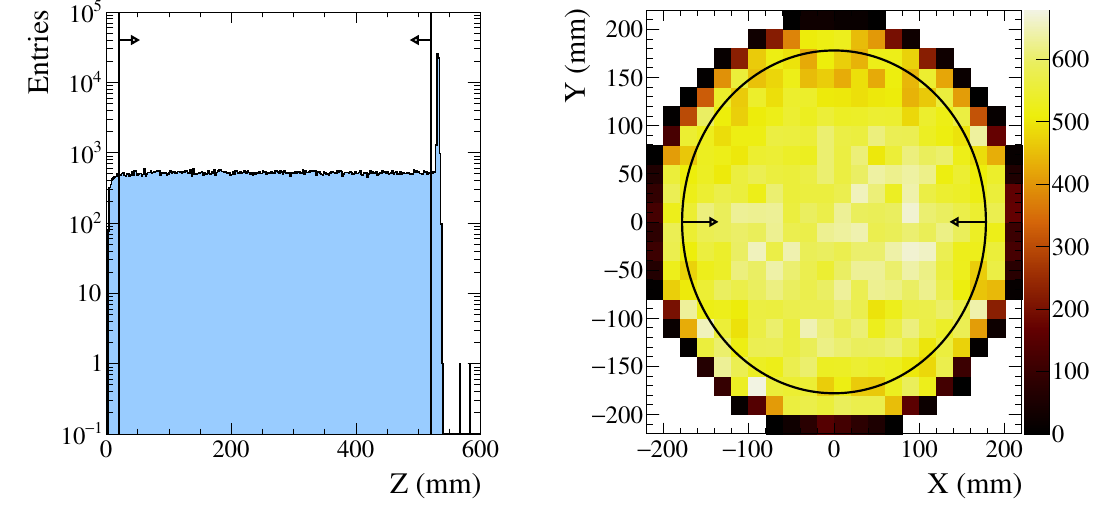
Figure 2 . Spatial distribution of alpha candidate events. Left panel: Z distribution. Right panel: distribution in the (X,Y) plane. In the two panels, the solid black lines and arrows indicate the (cid:12)ducial region.